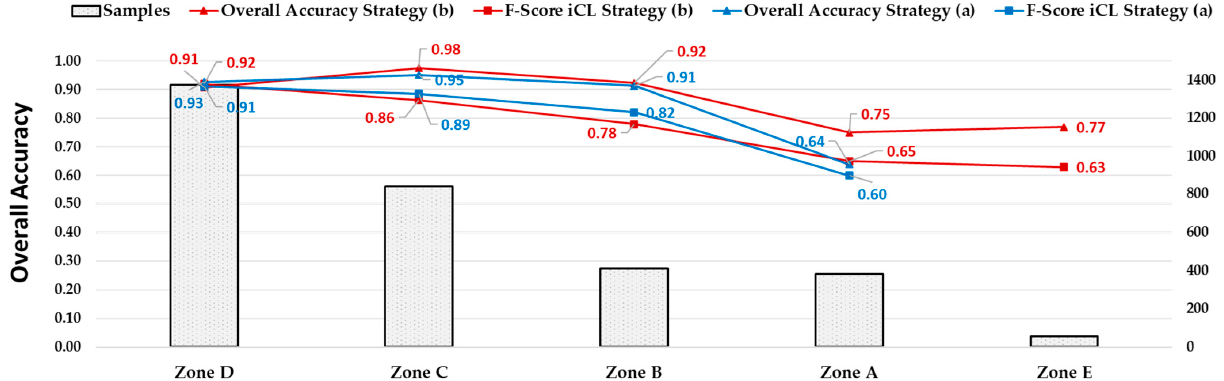
Figure 10. Global Accuracy (OA) and F ‐ score of the iCL class, obtained for the five climatic (A to E) and for the two spatial sampling strategies (datasets a and b). The histograms show the regions (A to E) and for the two spatial sampling strategies (datasets a and b ). The histo ‐ grams show the number of samples (given in pixels) available per region. number of samples (given in pixels) available per region.